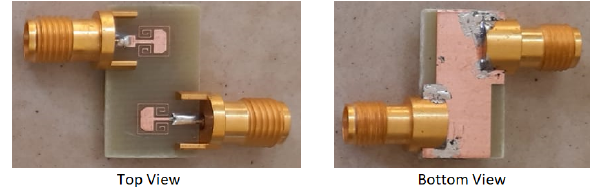
Figure 13. Fabricated prototype of the proposed